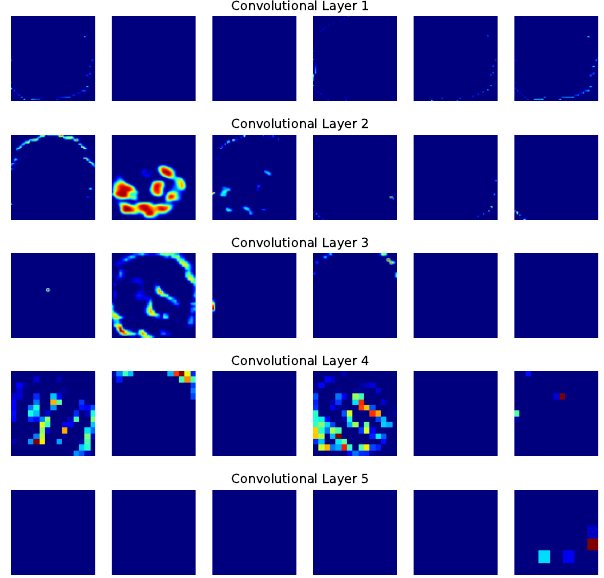
Figure 5. Visualizing Convolutional layers of CNN